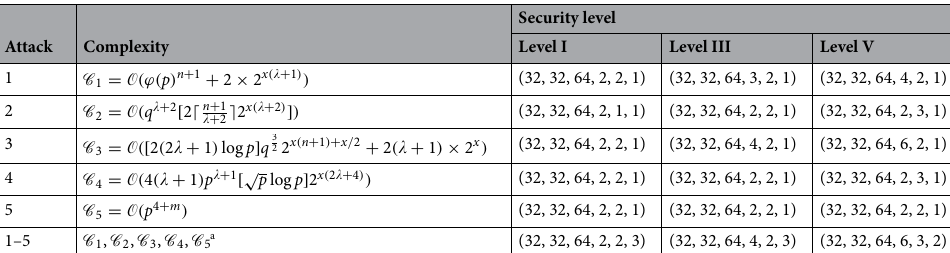
Table 2. Proposed MPPK/DS configurations to meet corresponding NIST Security level and avert corresponding attack, with values given as ( log 2 q , x , log 2 p , n , (cid:31) , m ) . a All the classical complexity estimations considered